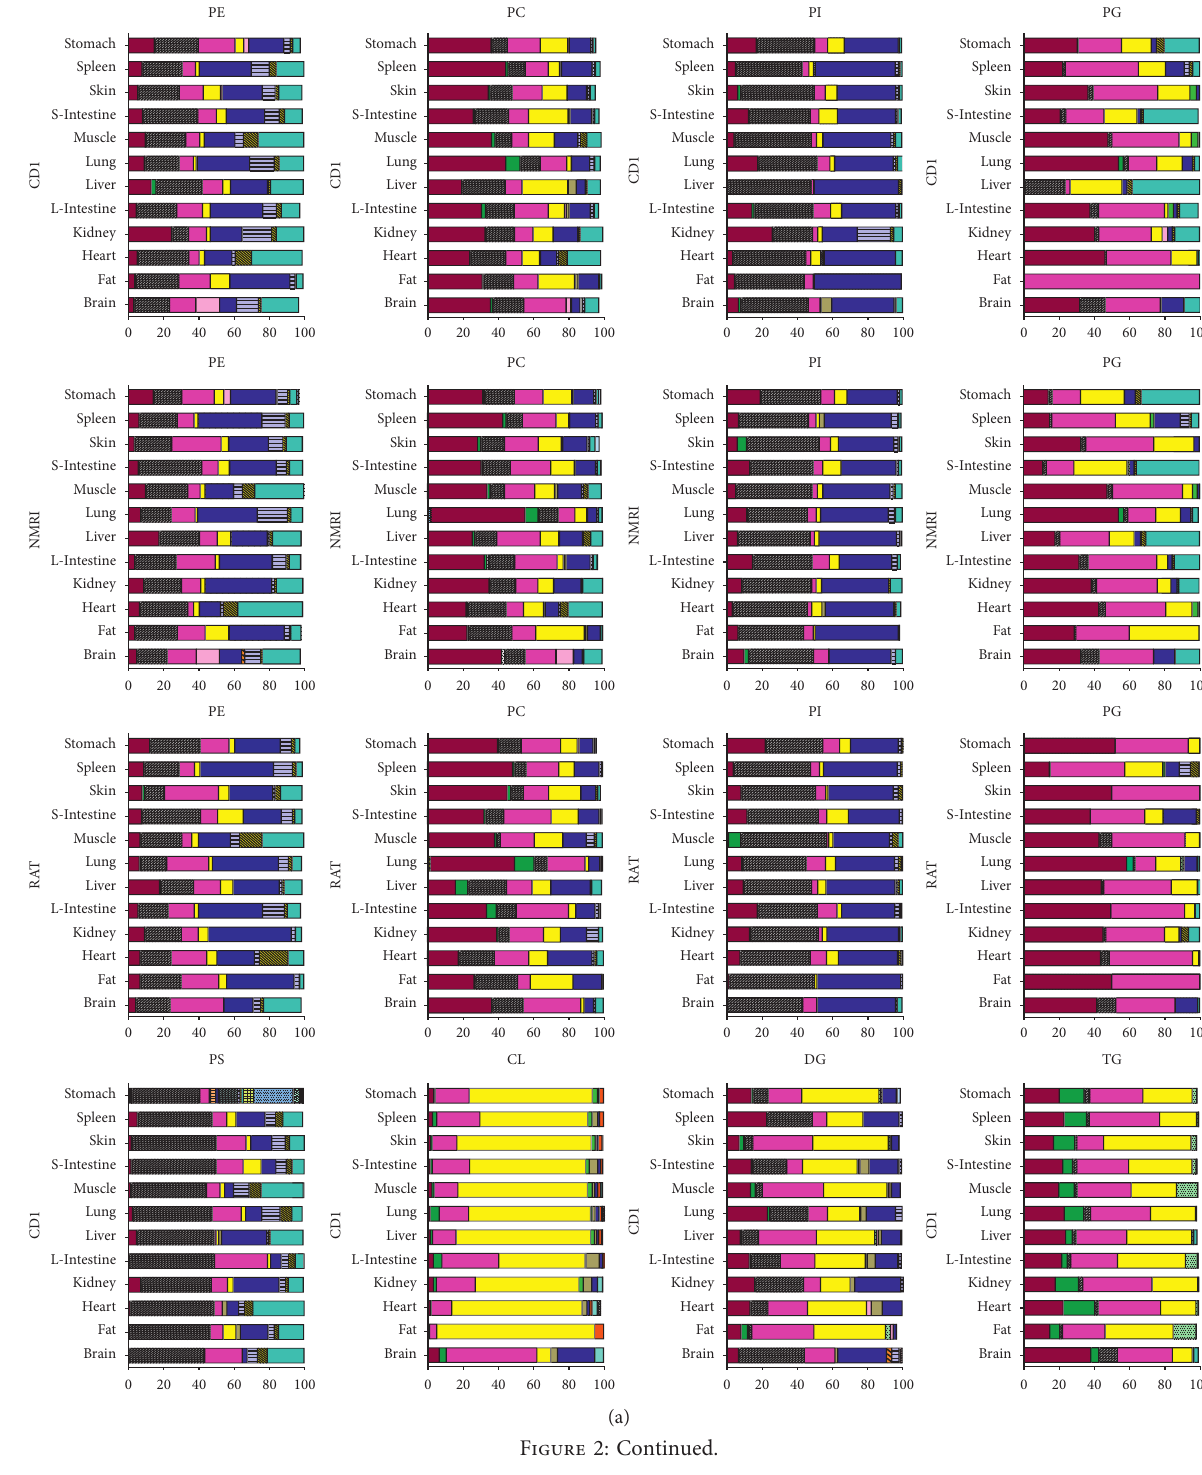
BrainFatHeartKidneyL-IntestineLiverLungMuscleS-IntestineSkinSpleenStomach D 1 C